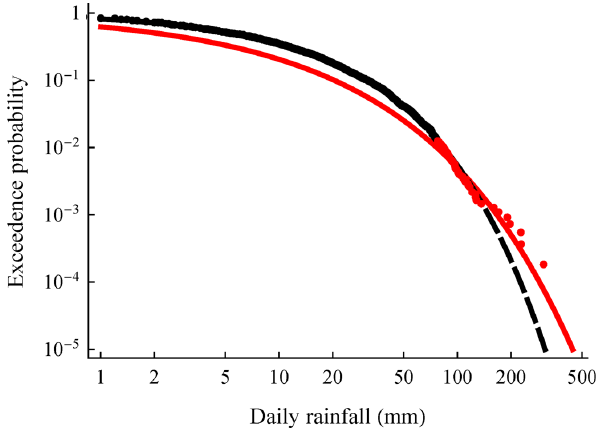
Fig. 3. Explanatory diagram of the fitting approach followed. The dashed line depicts a Weibull distribution fitted to the whole empir- ical distribution points, while the solid red line depicts the distribu- tion fitted only to the tail points.